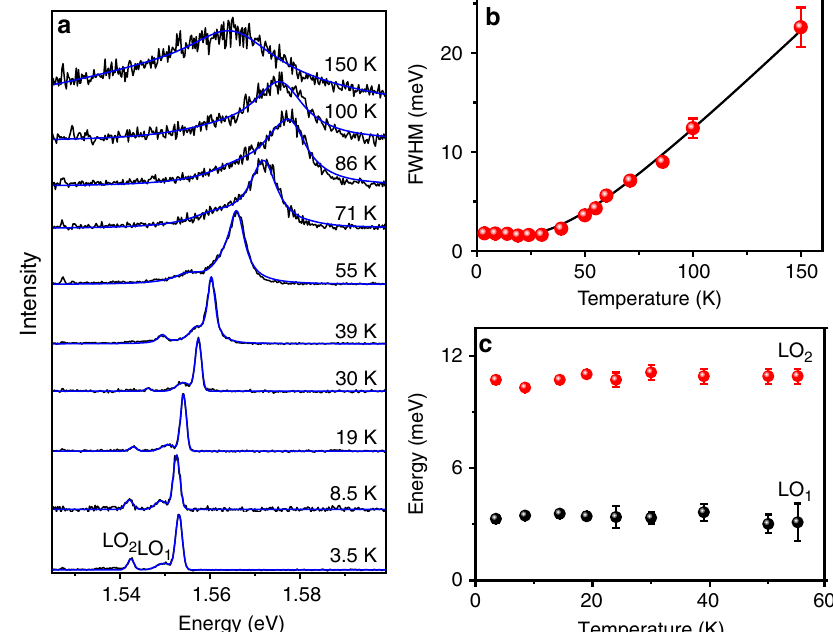
Fig. 3 Temperature dependence of the PL spectrum of a single FAPbI 3 NC. a Evolution of the PL spectrum of a FAPbI 3 NC with temperature. Each spectrum was recorded with an excitation intensity of 700 W cm − 2 . The spectra are fi tted (blue lines) with Gaussian pro fi les up to 30 K and with Lorentzian pro fi les above 30 K (see text). b ZPL linewidth (FWHM) of the same NC as a function of temperature. The black line is a fi tting curve taking into account only the Fröhlich coupling between the exciton and an effective LO phonon mode with energy E LO = (10.7 ± 0.8) meV. The low temperature linewidth is Γ 0 = 1.5 meV. The contribution of acoustic phonon to the line broadening is negligible as σ Ac <5 µ eV K − 1 . c LO 1 and LO 2 phonon energies as a function of temperature from 3.5 K to 55 K, deduced from the fi ts in a . The error bars displayed in b and c represent the fi tting errors of the parameters deduced from